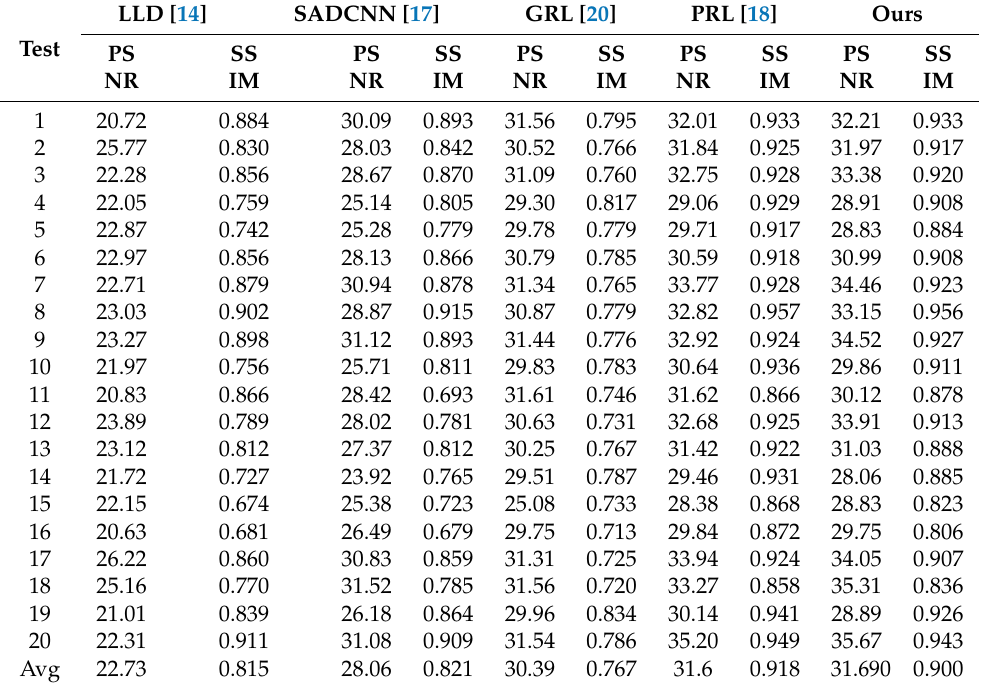
Table 4. Comparison on PSNR/SSIM obtained by different methods.